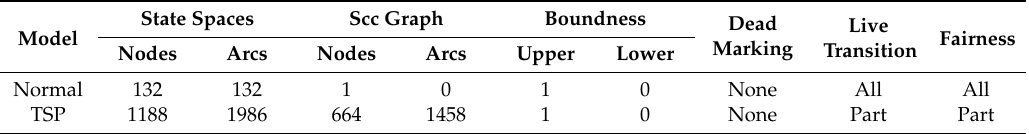
Table 3. Statistics of simulations of Hierarchical Colored Petri nets (HCPN) model. TSP: transit signal